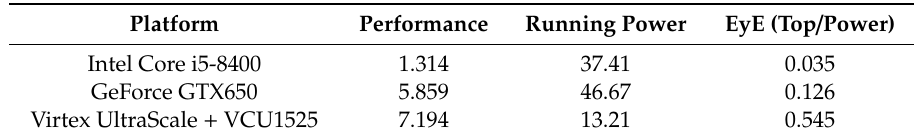
Table 8. Performance (MPoints / s, million sampling points per second), running power